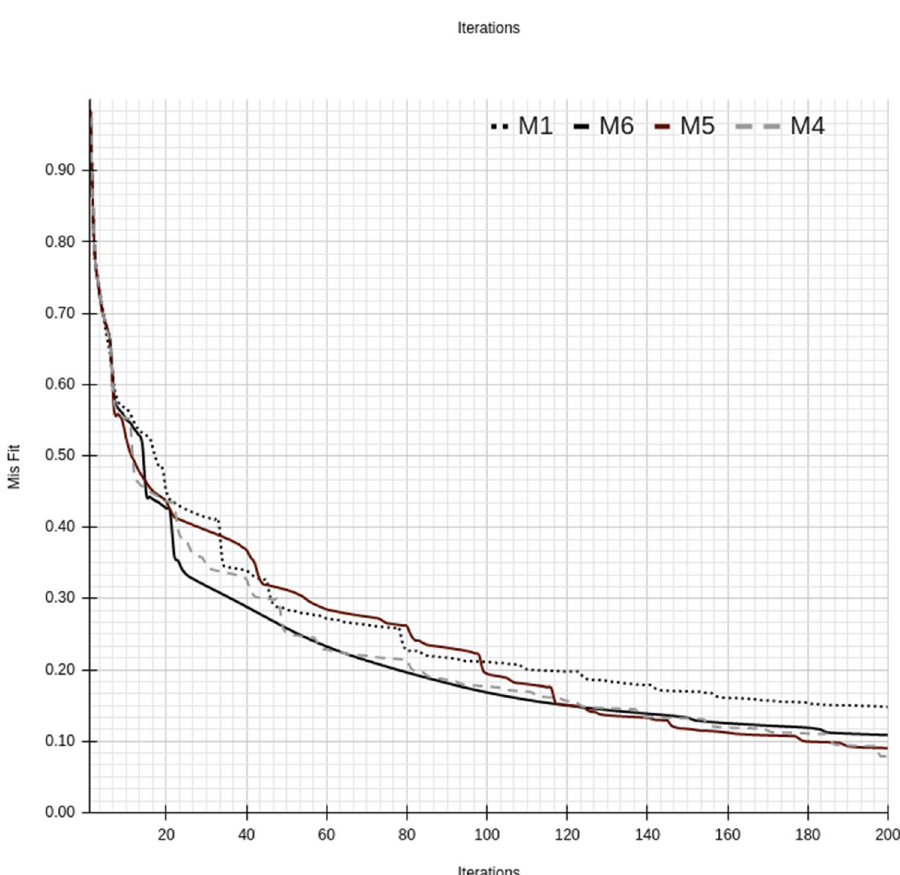
Fig. 7 Illustration of the misfit function for M1, M4, M5 and M6